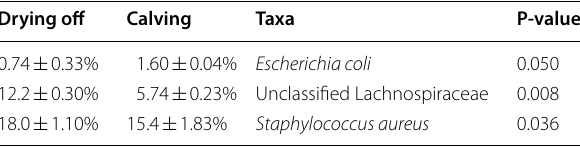
Table 1 Changes in relative abundances of dominant taxa between drying off and calving Drying off